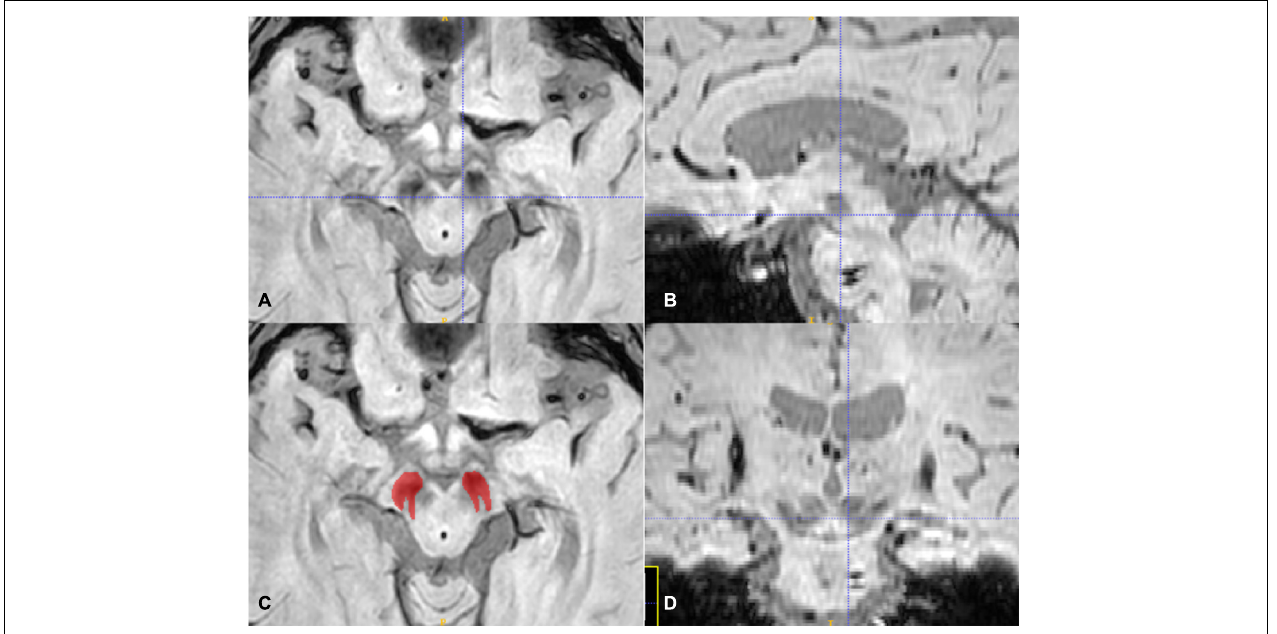
FIGURE 1 | The axis (A,C) , sagittal (B) , and coronal (D) plane of the SN, the crossline located at the middle area of the red nucleus in (A) and at the bottom of the red nucleus in (B,D) . The red ROI in (C) is according to the SN hypo-intensity area in (A)